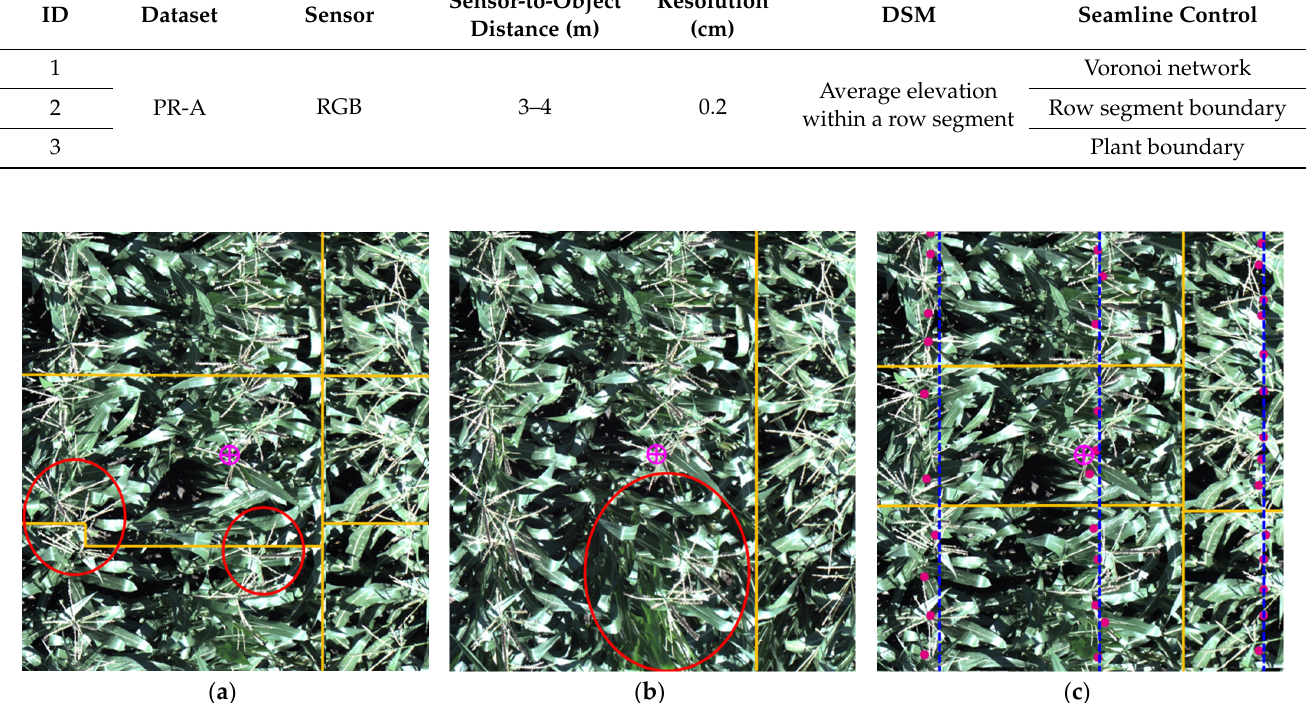
Figure 20. Generated orthophotos using PhenoRover frame camera images using different seamline control strategies: ( a ) Voronoi network seamline control, ( b ) row segment boundary seamline control, and ( c ) plant boundary seamline control (plant locations are shown as magenta dots and row centerlines are represented by blue dashed lines). The seamlines are represented by the yellow lines and the red ellipses highlight regions with discontinuity and relief displacement artifacts; the magenta circles in ( a – c ) refer to the same location (included for easier comparison of the visual quality of the different orthophotos).